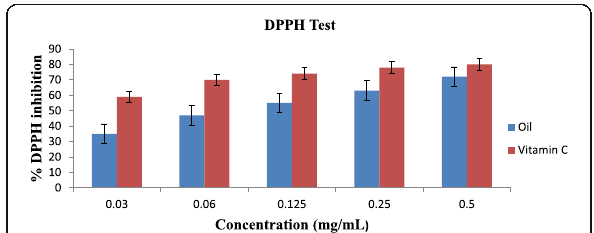
Fig. 4 Antioxidant effect of essential oil of T. minuta flower and vitamin C on lipid peroxidation